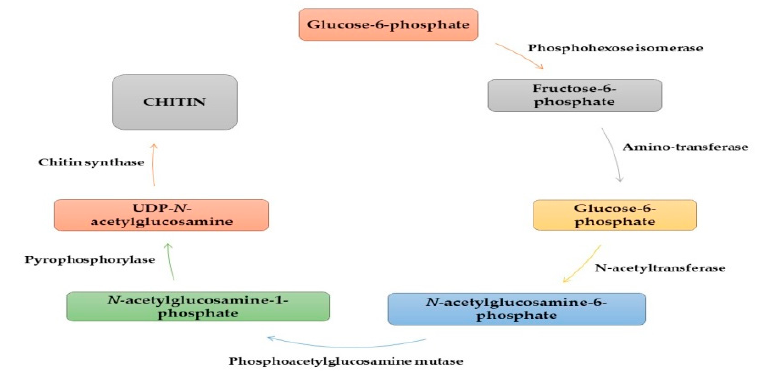
Figure 4. General scheme of chitin biosynthesis in biological systems.